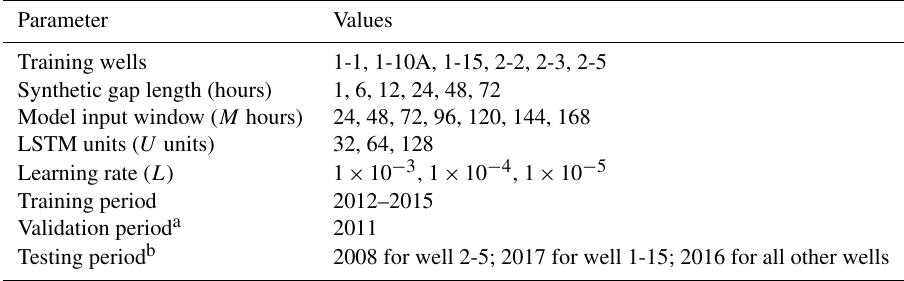
Table 1. Parameters used in training single-well LSTM